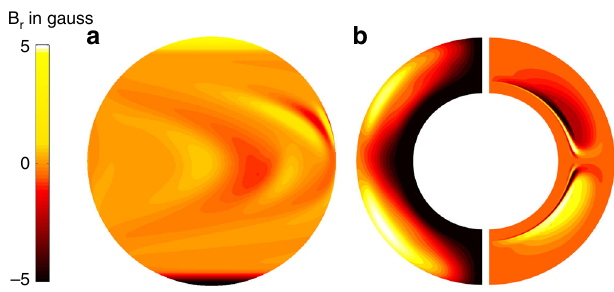
Fig. 3 Dynamo simulations of the Sun ’ s internal magnetic fi eld driven by surface inputs. a Solar surface fl ux transport model prediction of the Sun ’ s surface magnetic fi eld distribution near cycle 24 minimum. b Left: The poloidal fi eld distribution within the Sun ’ s convection zone in the internal dynamo model following assimilation of the data from the surface fl ux transport model. b Right: The dynamo model predicted toroidal fi eld within the Sun ’ s convection zone during cycle